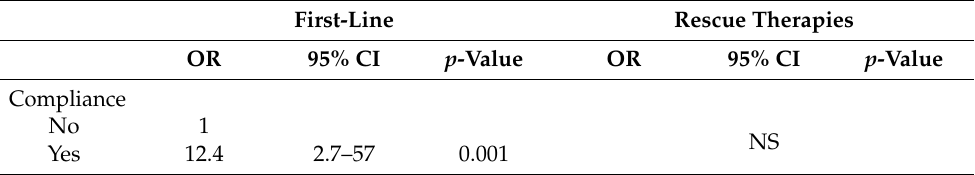
Table 10. Multivariate analysis of mITT effectiveness according to culture-guided prescribed